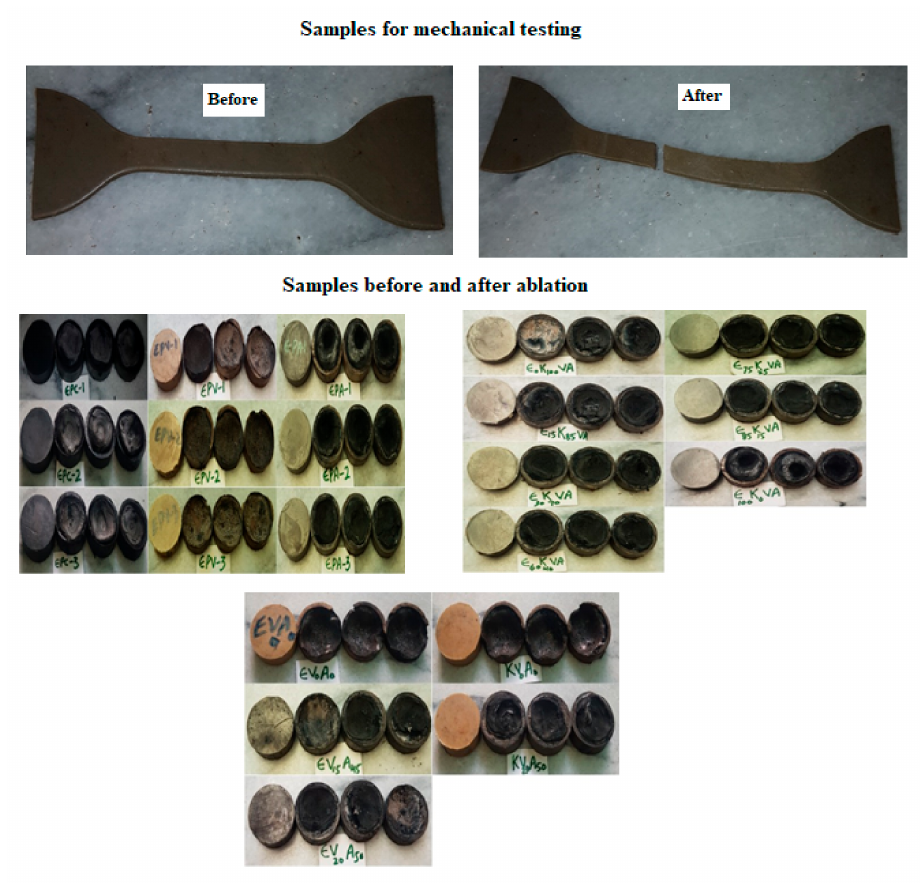
Figure 2. Top: Dumbbell-shaped samples before and after mechanical testing. Bottom: The samples before and after ablation rate test, where each sub figure represented first sample before and remaining three samples after ablation